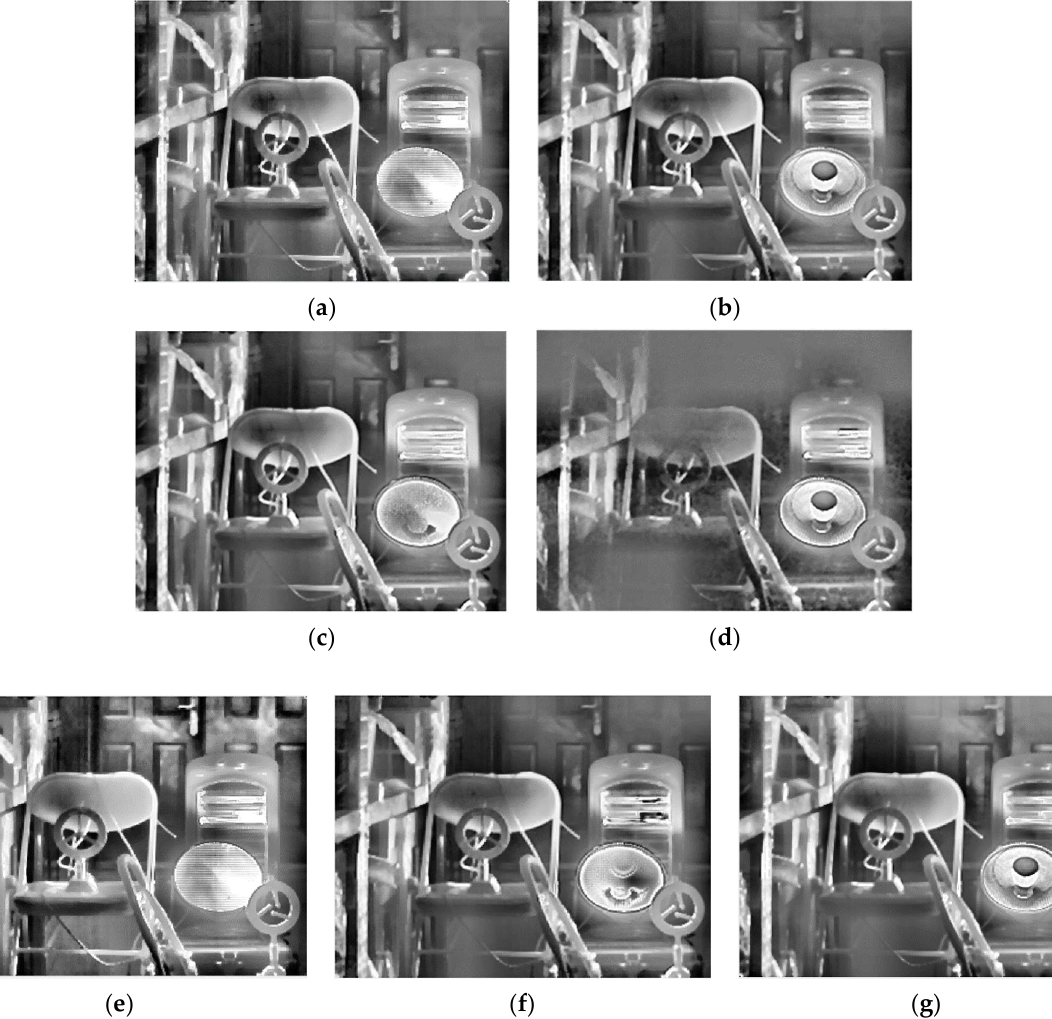
Figure 13. HDR fusion results for scene 1 with different selection methods: ( a ) single integration time (1050 μs); ( b ) ES; ( c ) EI; ( d ) MGD; ( e ) MW&EN; ( f ) ME; ( g ) proposed.